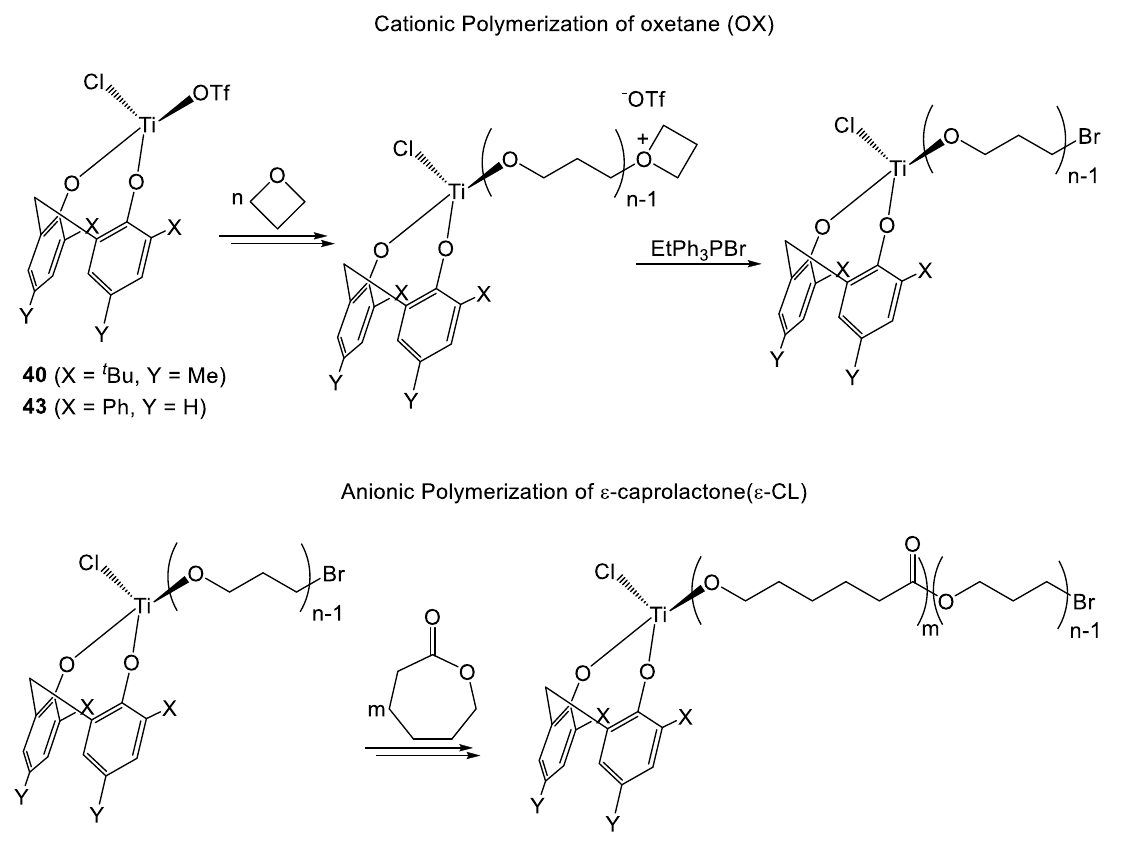
Figure 11. Diphenolate complexes employed in ROP of oxocyclic monomers